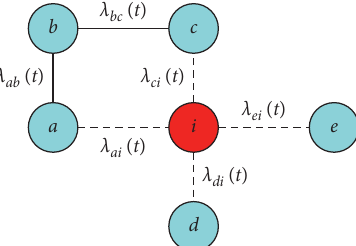
Figure 4: The analysis of traffic redistribution